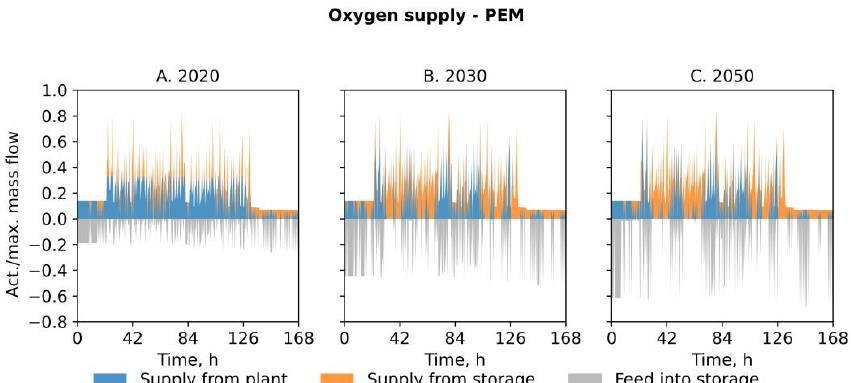
In contrast, the electrolysis implemented in scenario PEM operates over the full load